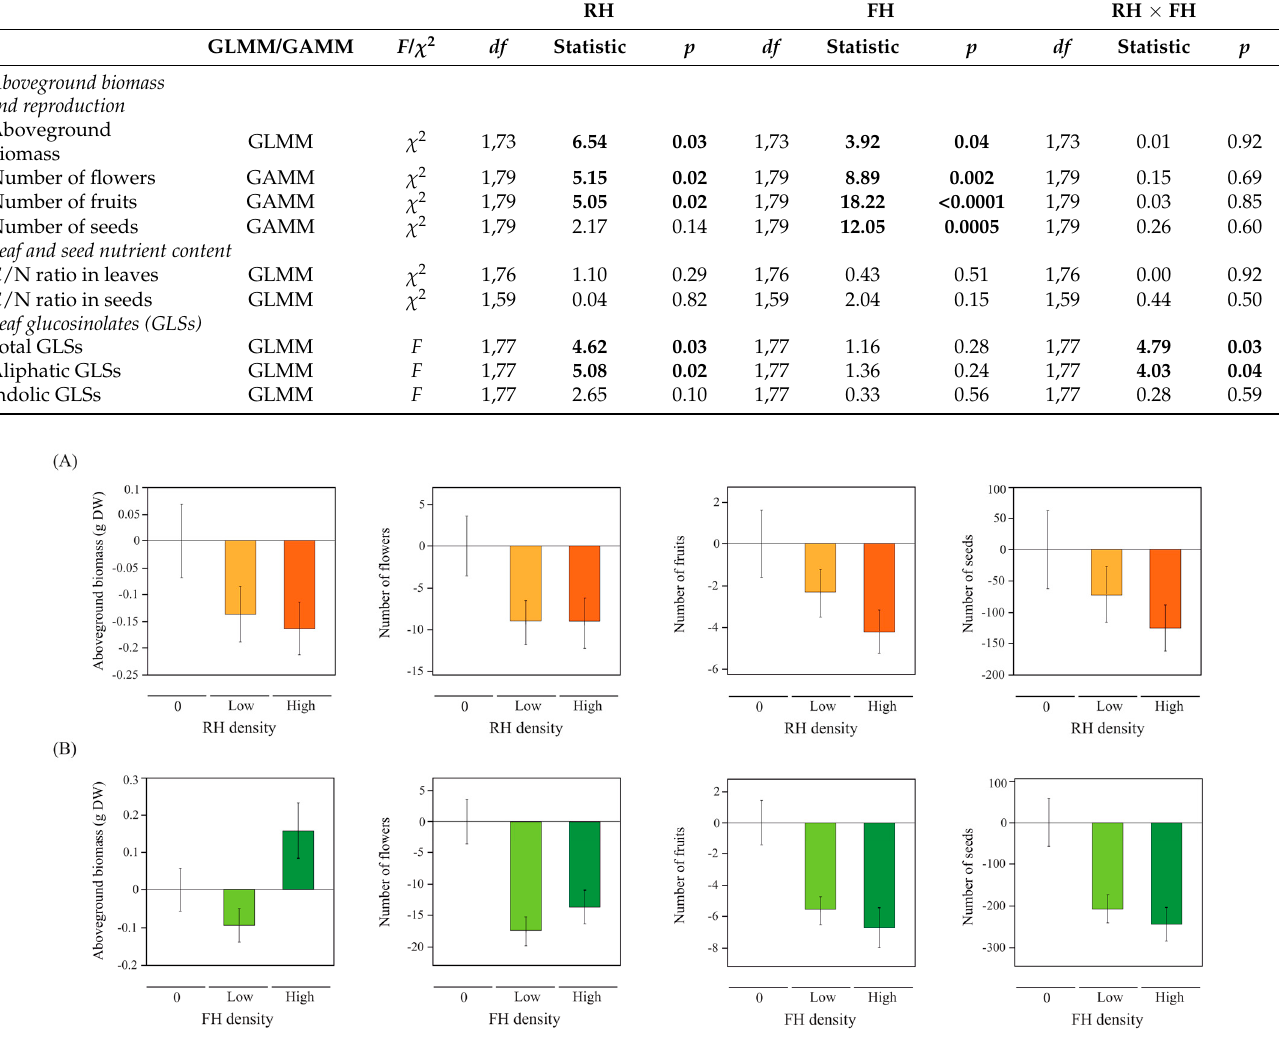
Figure 2. ( A ) Root herbivore (RH) density effects on plant aboveground biomass and reproductive traits. Shown values (mean ± SE) are relative to mean RH 0 = 0, plants with no RH (see absolute values in Supplementary Material 2, Figure S1). White bars are shown for 0 RH density (RH 0 plants, absence of RH), orange bars are shown for low RH density (RH 1 plants, one RH individual), red bars are shown for high RH density (RH 2 plants, two RH individuals). ( B ) Floral herbivore (FH) density effects on plant aboveground biomass and reproductive traits. Shown values (mean ± SE) are relative to mean FH 0 = 0, plants with no FH (see absolute values in Supplementary Material 2, Figure S1). White bars are shown for 0 FH density (FH 0 plants, absence of FH), light green bars are shown for low FH density (FH 1 plants, one FH individual), dark green bars are shown for high FH density (FH 2 plants, two FH individuals).